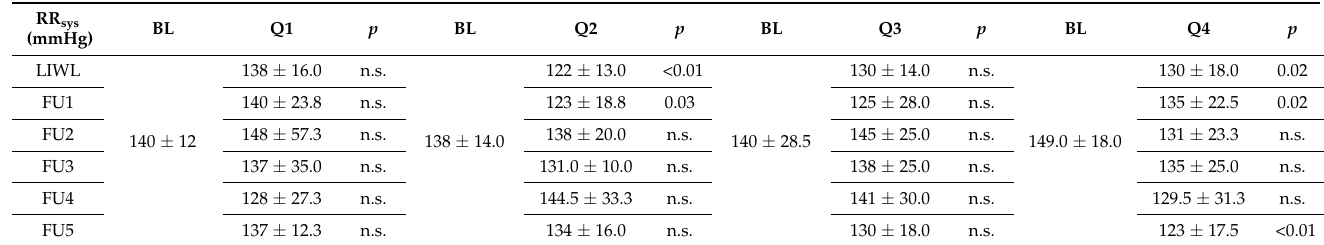
Table 5. Median and interquartile ranges of RR sys levels before and after LIWL and during the 5-year